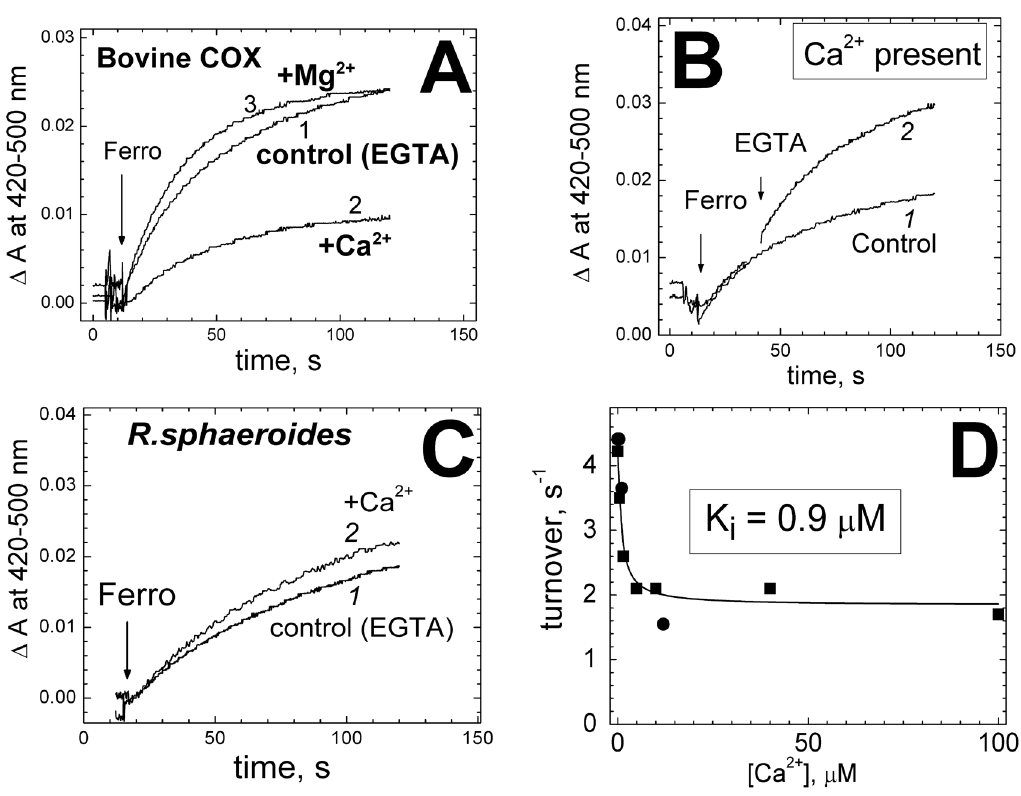
Figure 2. Ca 2 + ions inhibit cytochrome c- catalyzed oxidation of ferrocyanide by cytochrome oxidase. ( A ) 0.3 m M bovine COX in the basic medium (100 m M EGTA present) with 40 nM cytochrome c . Where indicated, 1 mM ferrocyanide (ferro) was added, and its oxidation to ferricyanide was followed spectrophotometrically at 420 nm vs the 500 nm reference. Trace 1 , control recording; trace 2 , + 200 m M CaCl 2 (100 m M excess over EGTA); trace 3 , + 0.4 mM Mg 2 + (300 m M excess over EGTA). ( B ) Conditions, as in panel A, trace 2 (100 m M excess of CaCl 2 over EGTA). In trace 2 , 300 m M EGTA has been added. ( C ) 0.2 m M wild-type COX from R.sphaeroides . Trace 1 , control (100 m M EGTA). Trace 2 , with 200 m M CaCl 2 . ( D ) Concentration dependence of the inhibition. Initial rate of ferrocyanide oxidation by COX (0.3 m M) is plotted vs concentration of free Ca 2 + buffered with 1 mM NTA (squares) or 1 mM BAPTA (circles). The curve corresponds to K i of 0.9 m M and maximal inhibition of 60%.